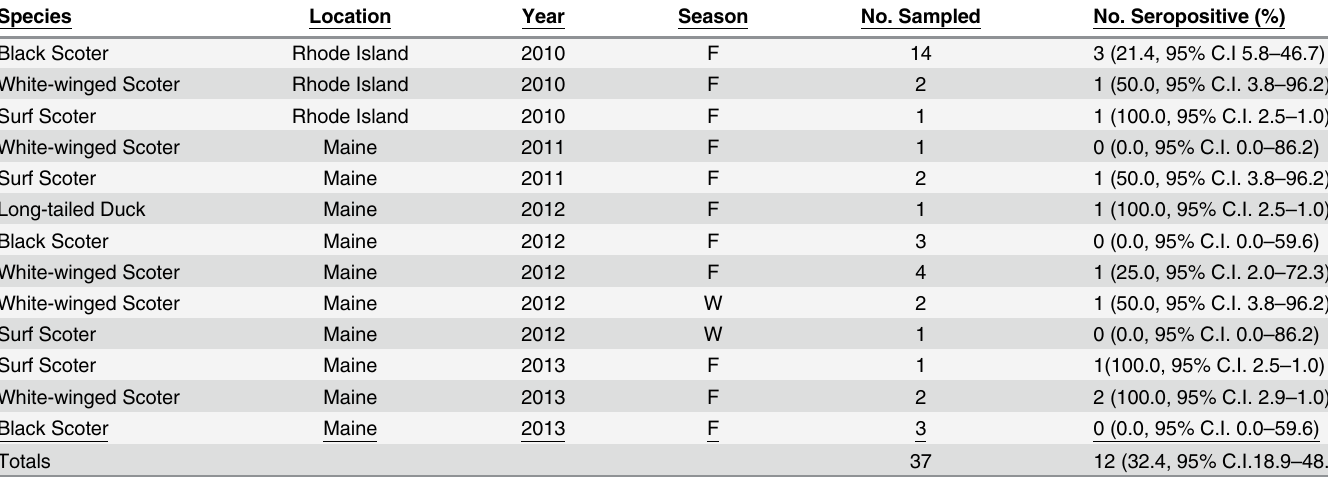
Table 2. Detection of avian influenza antibodies in North Atlantic sea ducks other than common eiders.